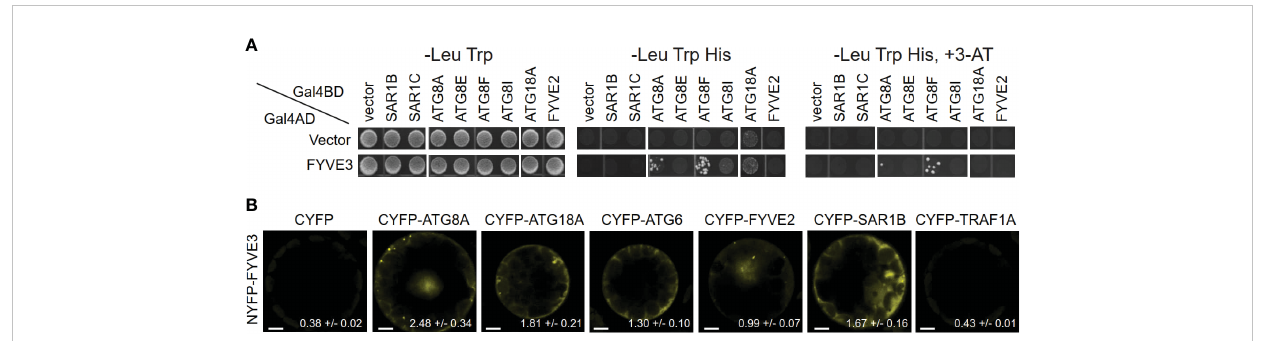
FIGURE 1 FYVE3 interacts with ATG8 and associates with FYVE2-related autophagic machinery. (A) Yeast two-hybrid (Y2H) interactions of FYVE3 with select ATG8 isoforms. Gal4BD, Gal4 binding domain; Gal4AD, Gal4 activation domain; 3-AT, 3-amino-1,2,4-triazole. (B) Bimolecular fl uorescence complementation (BiFC) interactions of FYVE3 in Arabidopsis protoplasts. Quanti fi cation of overall reconstituted fl uorescence is shown at the bottom of each image (mean ± S.E.; n = 30 to 37 images). Scale bars = 5